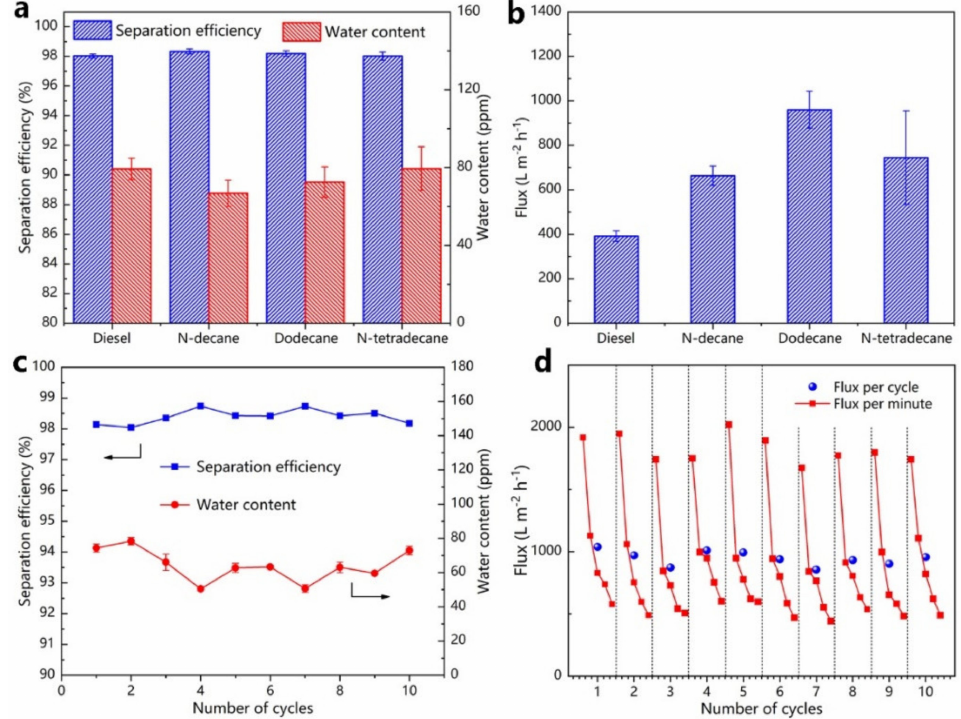
Figure 9. The separation efficiency and water content in ( a ) water-in-oil emulsions filtrates; ( b ) filtration fluxes of various water-in-oil emulsions; ( c , d ) the recycling separation performance of ZnO coated filter membrane for water-in-oil